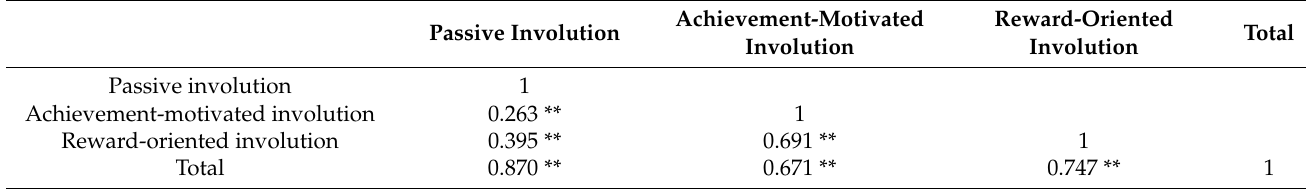
Table 3. Internal consistency validity of the involution